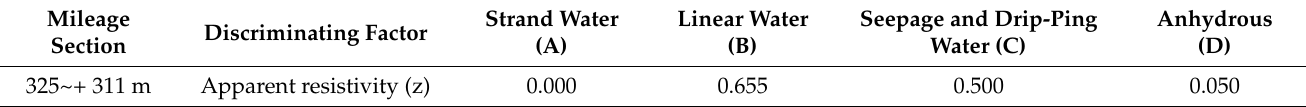
Table 4. Membership degree of GPR identification factors to fuzzy sets.